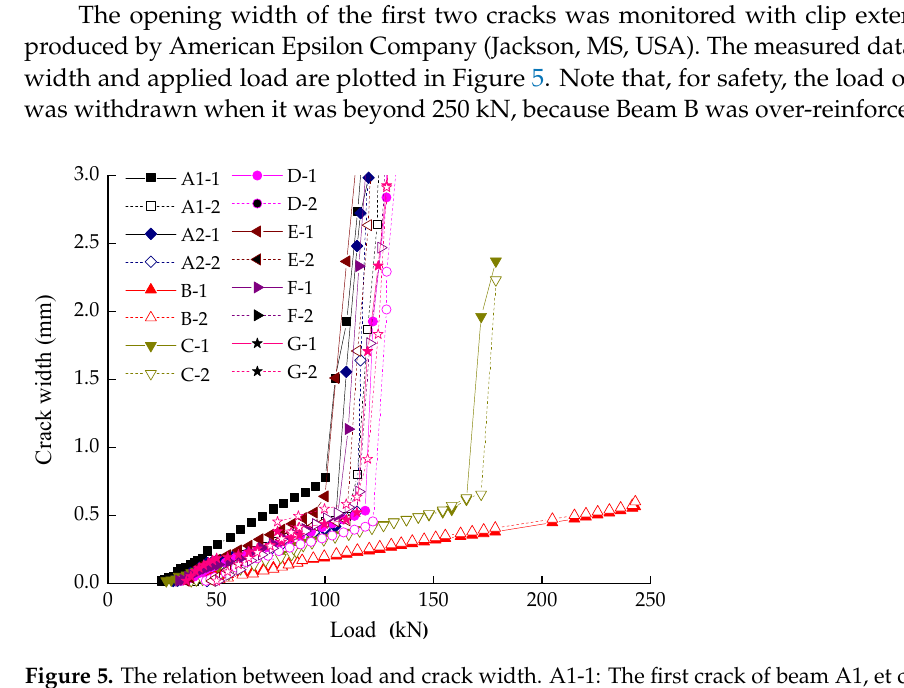
Figure 5. The relation between load and crack width. A1-1: The first crack of beam A1, et cetera. G-2: The second crack of beam